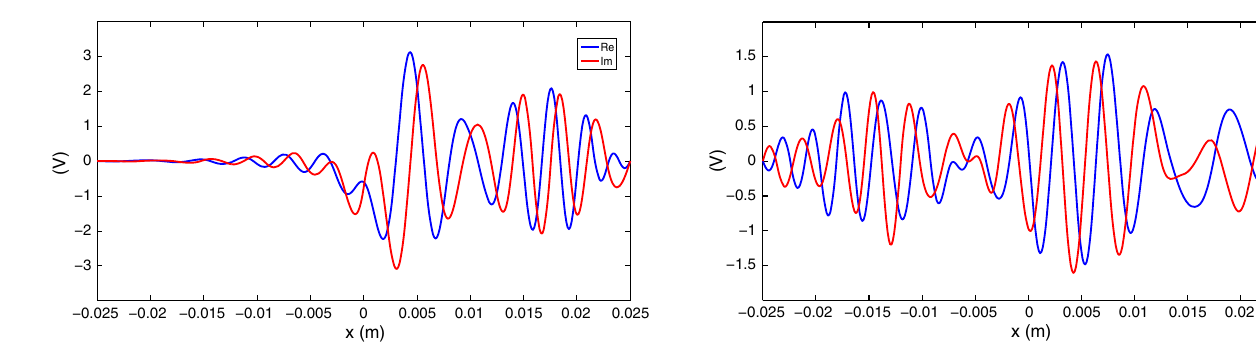
FIG. 12. The sum to p ¼ 9 of the straight after the bend ( s ¼ 1 . 55 m) for kR ¼ 5 × 10 5